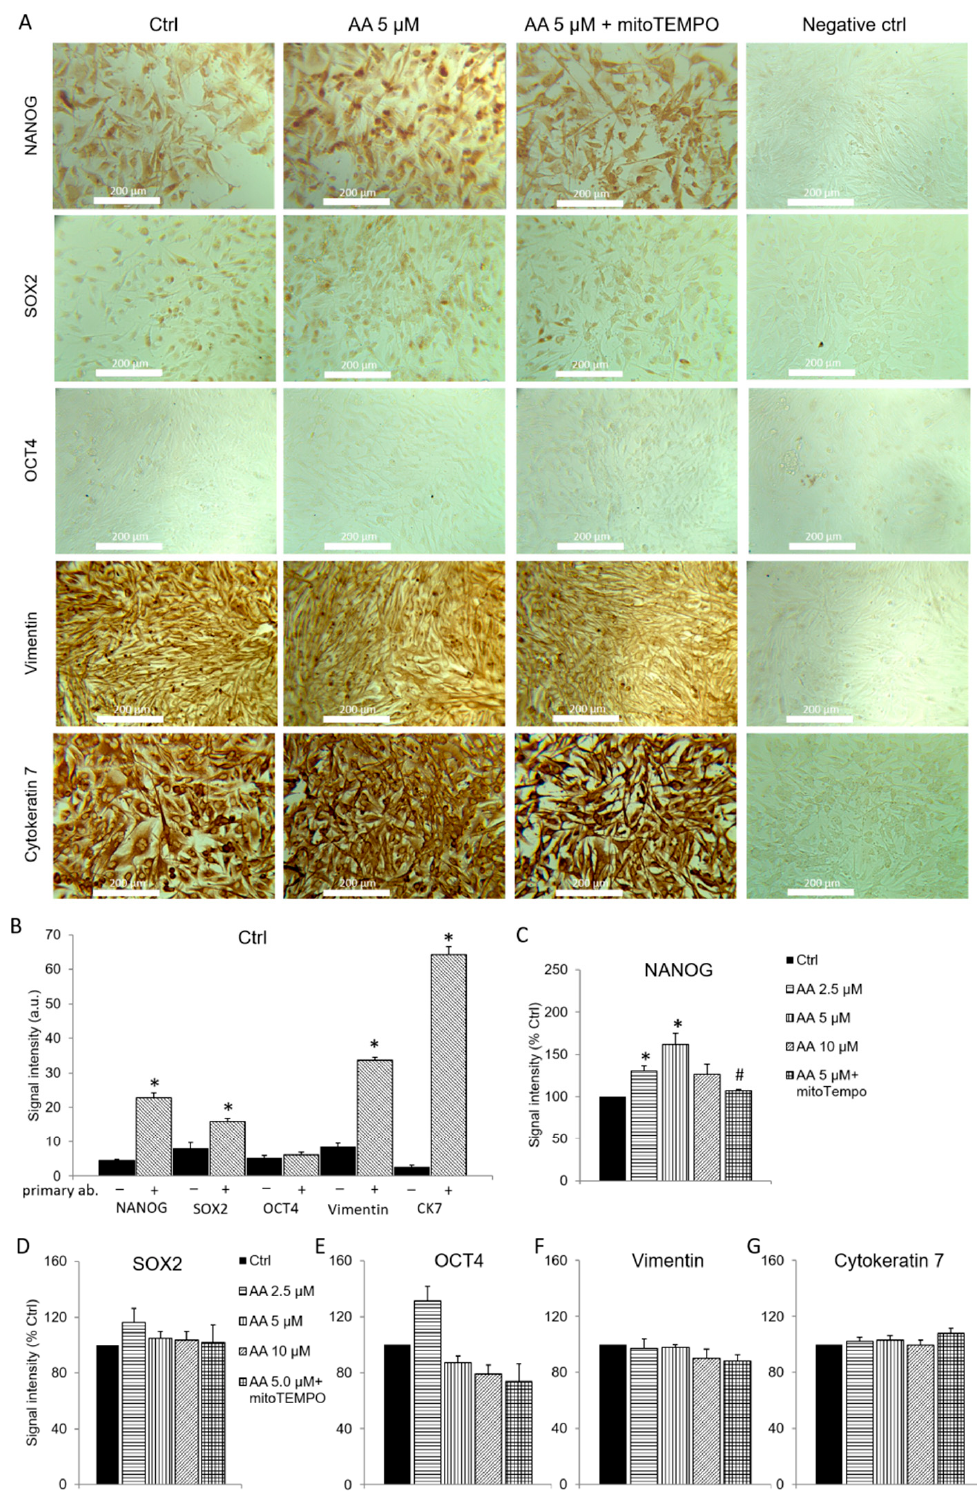
Figure 5. OCT4, NANOG and SOX2 proteins in mesothelioma cell line. ( A ) Representative images of immunocytochemical analysis of protein expression in Mero-14 cells. ( B ) Summary data of protein expression determined by DAB densitometry quantification. The intensity of signal with ( + ) and without ( − ) primary antibody is presented and subjected to statistical comparison in control cells (Ctrl). The expression of NANOG ( C ), SOX2 ( D ) and OCT4 ( E ), as well as control mesothelioma markers vimentin ( F ) and cytokeratin 7 ( G ) were analyzed in response to different antimycin A concentrations, with or without mitoTEMPO. Data are means±SEM; n = 8/group. * p < 0.05 vs Ctrl. 4. Discussion We demonstrated that human mesothelium and mesothelioma express NANOG and SOX2 proteins and POU5F1 , NANOG and SOX2 genes. Compared to normal mesothelium, mesothelioma exhibited higher expression of NANOG and SOX2 proteins and lower expression of POU5F1 ,